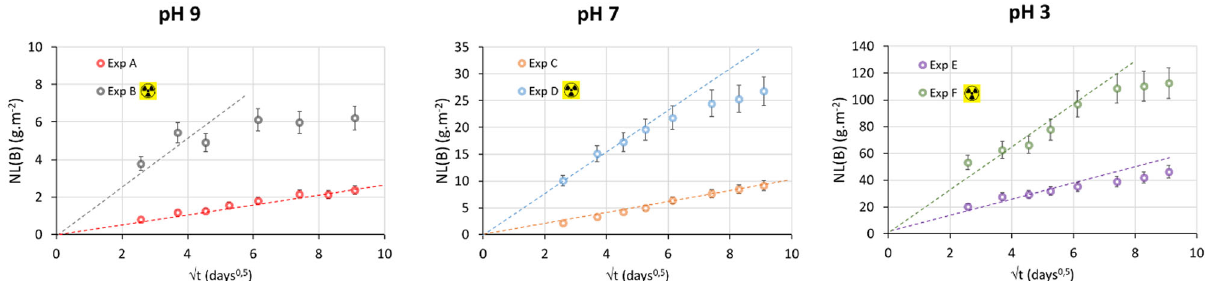
Fig. 5 Normalised mass losses of B as a function of the square root of time for the experiments at pH 9, pH 7, and pH 3. Exp. A, C, E = non- irradiated samples, Exp. B, D, F = irradiated samples. Despite slight variations due to B retention in gels, NL(Na) followed the same trends. The dotted lines are a visual guide to show a linear slackening as a function of the square root of